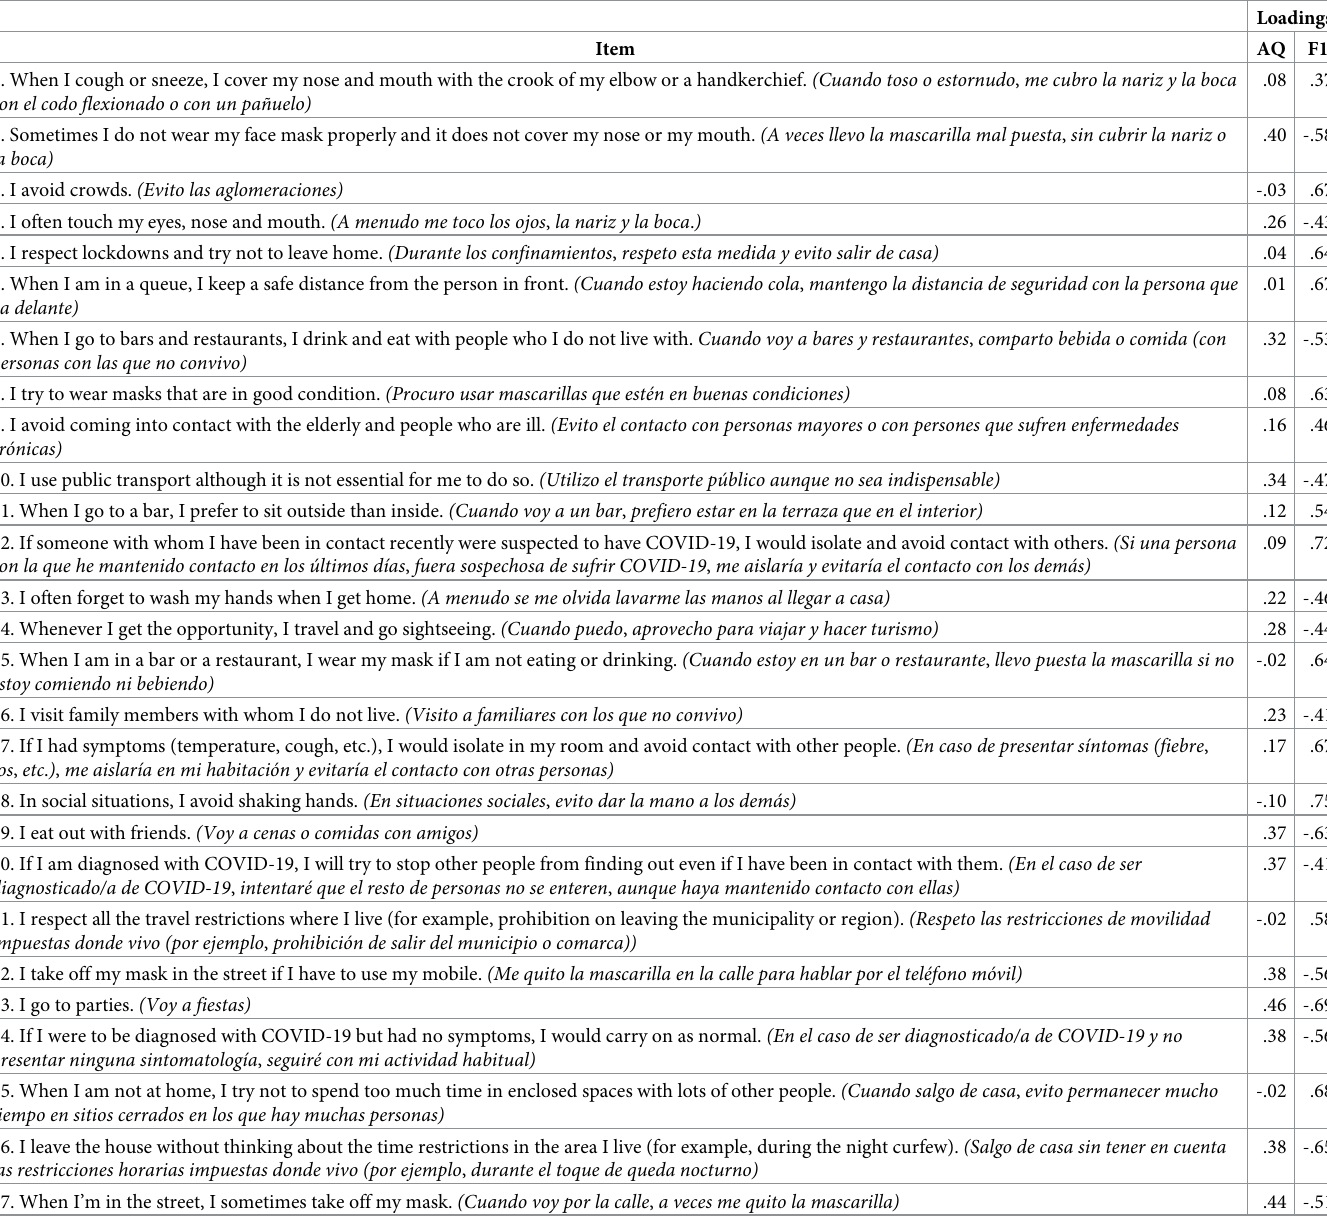
Table 1. Loading matrix obtained from the exploratory factor analysis, means and standard deviations of the whole